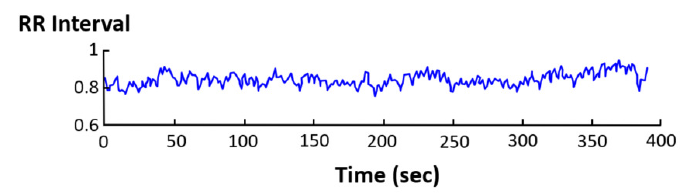
Figure 3. Example of a signal obtained from ECG R–R intervals.